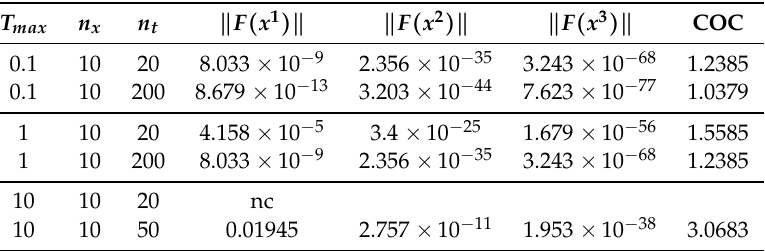
Table 3. Fisher results by CJST5 and different T max